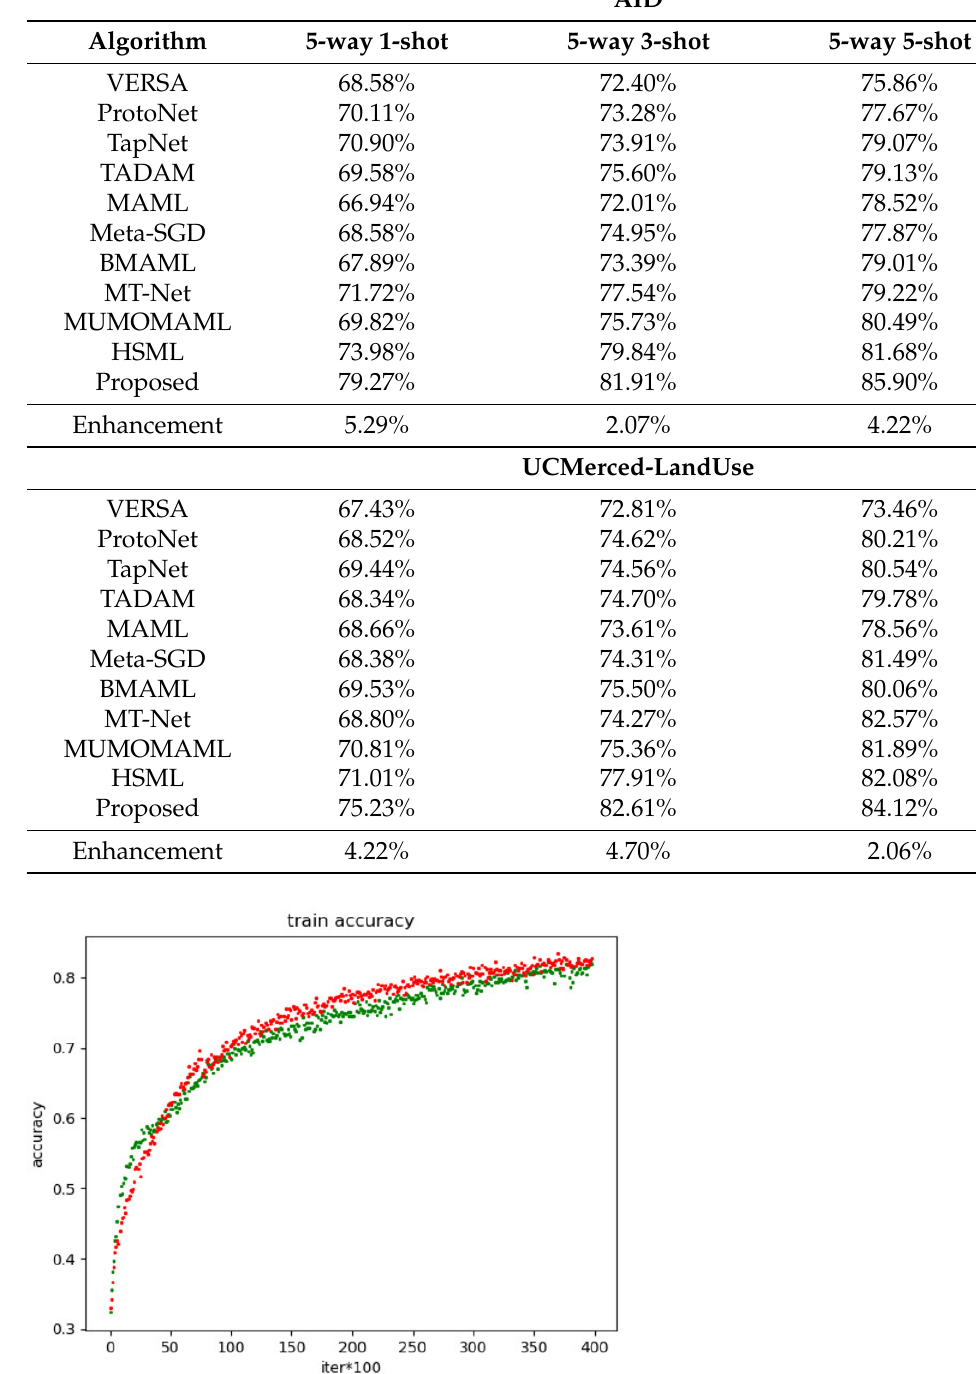
Figure 5. Comparison of accuracy between our proposed method and a task-heterogeneous meta- learning process, where the red dots represent task-covariant learning and the cyan dots represent task-heterogeneous